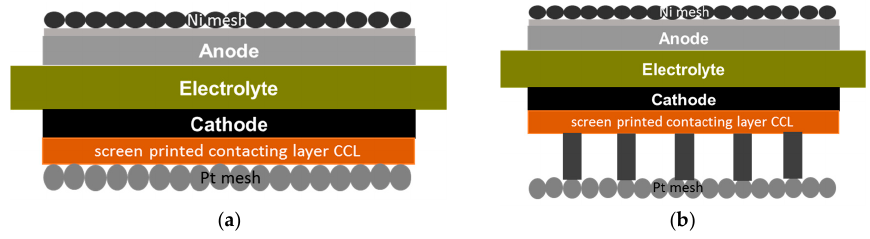
Figure 10. Evaluation of cell and CCL resistances ( a ) and simulation of stack situation ( b ).